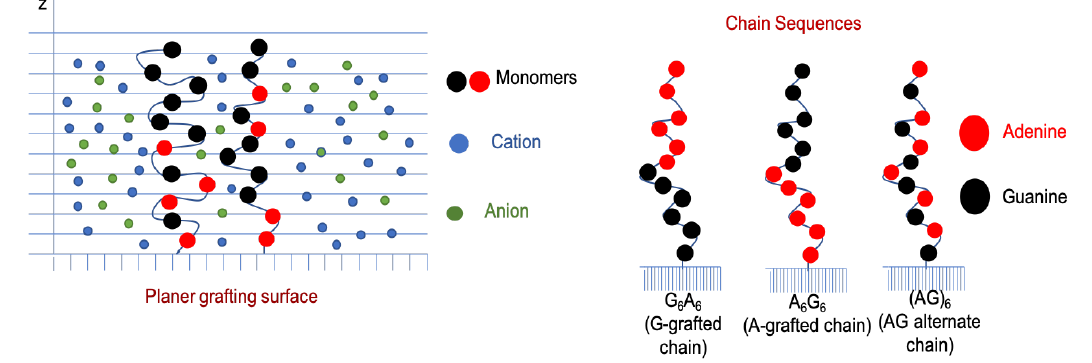
Figure 1. Schematic representation of an end-grafted polymer in a salt solution environment ( left ) and chain sequences used for molecular modeling ( right